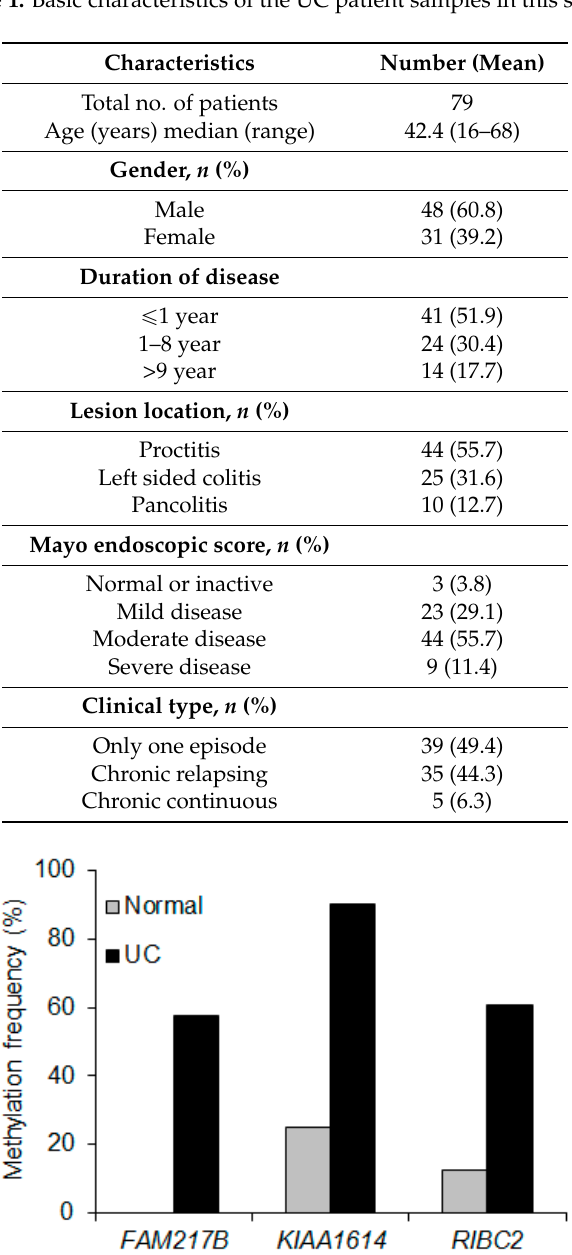
Table 1. Basic characteristics of the UC patient samples in this study.